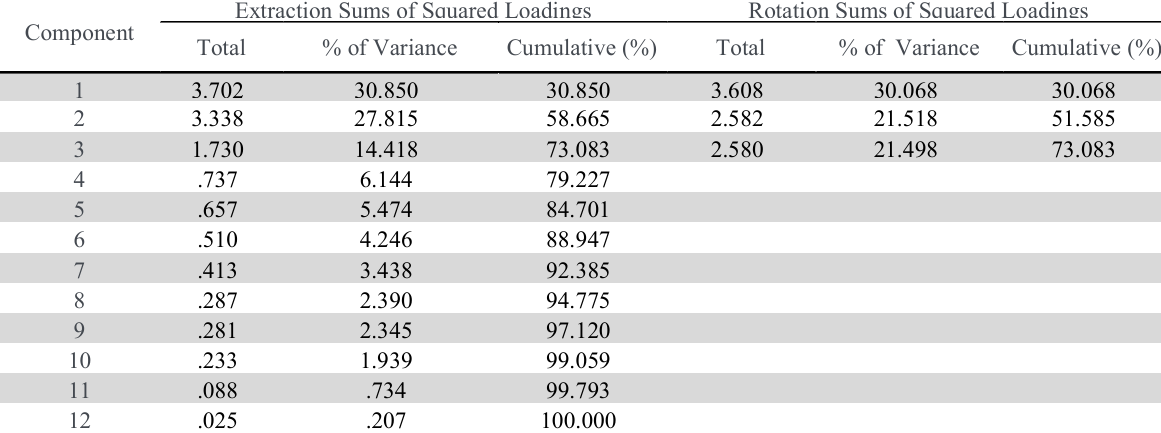
Total variance explained